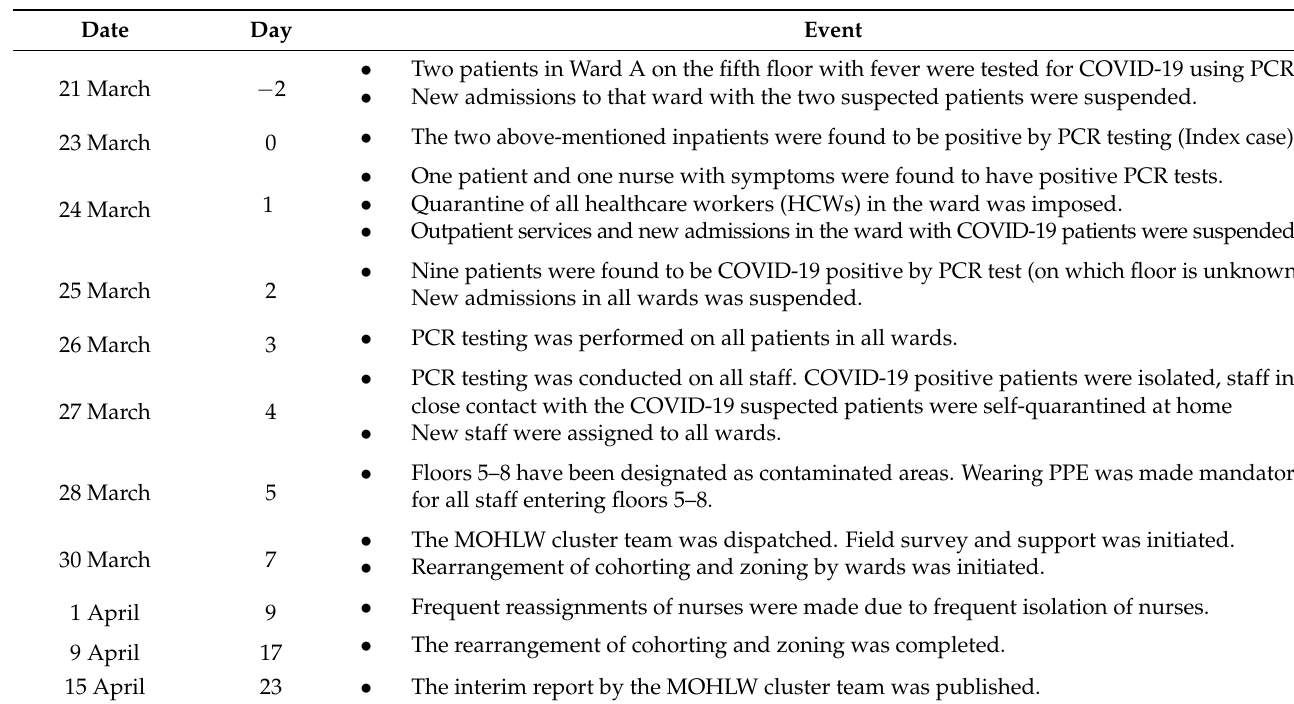
Table 3. Timeline of events at Hospital